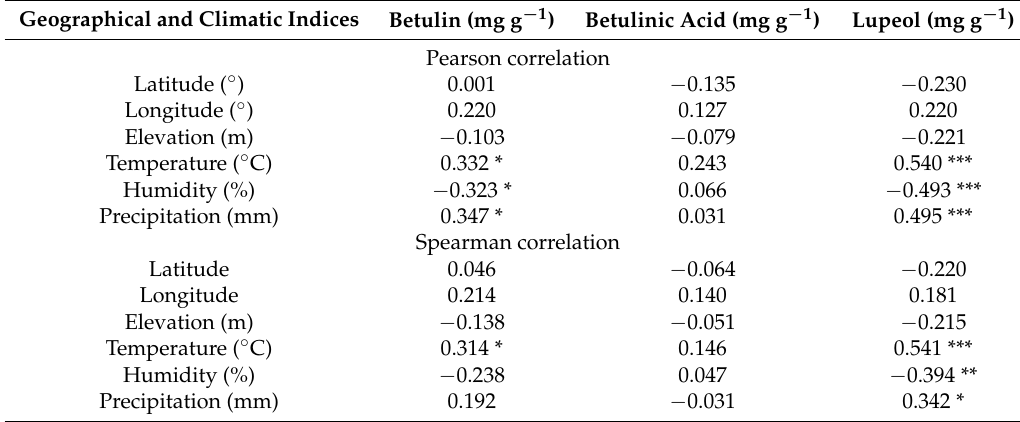
Table 3. R values from correlation between concentrations of three triterpenoids (betulin, betulinic acid and lupeol) in white birch trees and climate factors in Northeast China ( n =